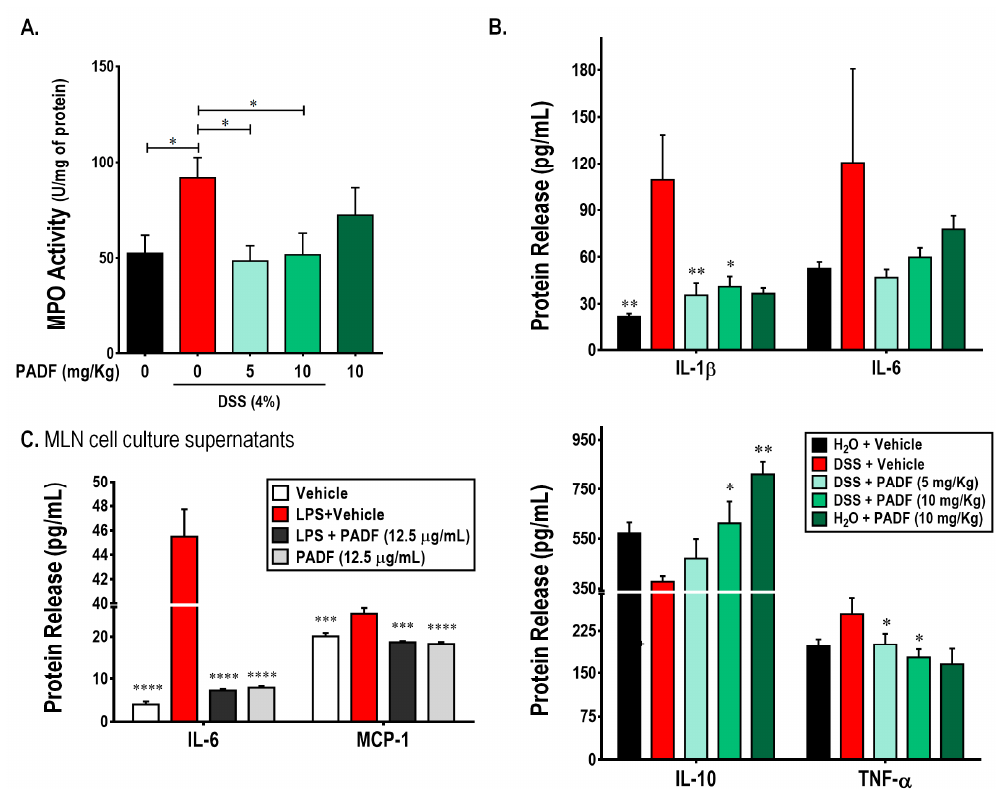
Figure 3. P. angulata fraction (PADF) exerts immunoregulatory e ff ect in cells from colon and mesenteric lymph nodes (MLNs). The administration of PADF to mice with chronic colitis induced a significant reduction in the infiltration of neutrophils as demonstrated by a strong reduction of myeloperoxidase (MPO) activity ( A ). In addition, PADF regulated the levels of pro-inflammatory cytokines (IL-1 β and TNF- α ), while significantly induced the production of IL-10, an anti-inflammatory cytokine ( B ). PADF also reduced the release of IL-1 β and IL-6 by MLN cells activated with LPS ( C ). Results represent the mean ± SEM from at least two independent experiments ( n = 6–16). * p < 0.05, ** p < 0.01, *** p < 0.001, **** p < 0.0001 from DSS-colitis control group or LPS-activated MLN cells (ANOVA, Dunnett’s multiple comparisons